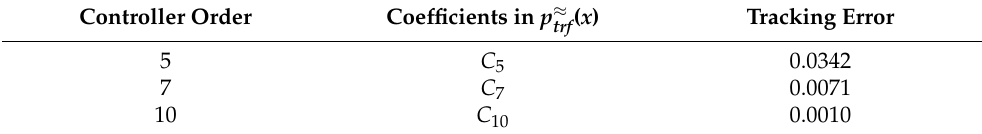
Table 3. Coefficients and tracking errors of controllers under multi-Gaussian distribution. Controller Order